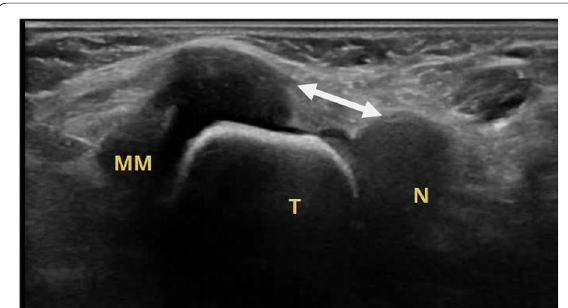
Fig. 6 Ultrasound scan dorsal sagittal view of the left foot for a 12-day-male newborn, presenting with club foot, which shows a